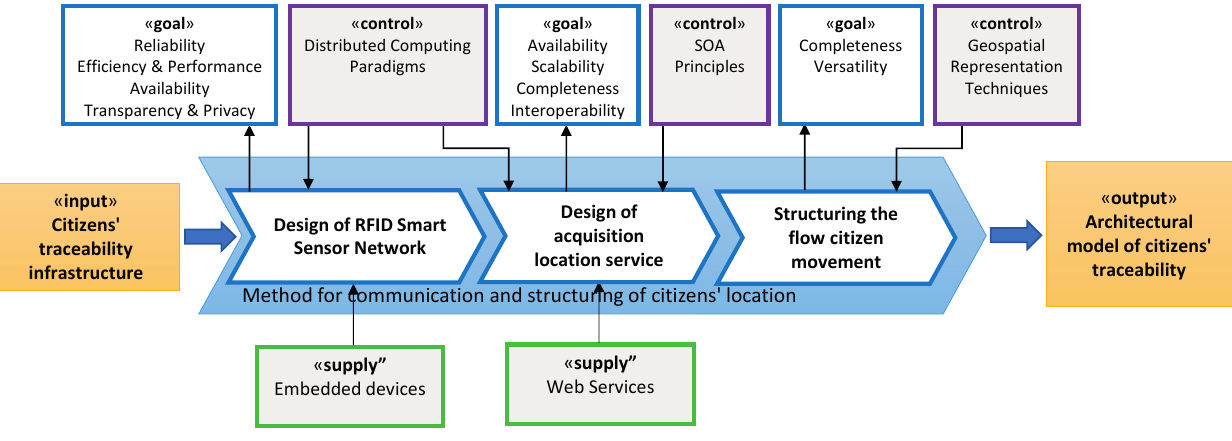
Figure 6. Modelling with Eriksson-Penker notation of the details of the process Design of the method for communication and structuring of citizens’ location